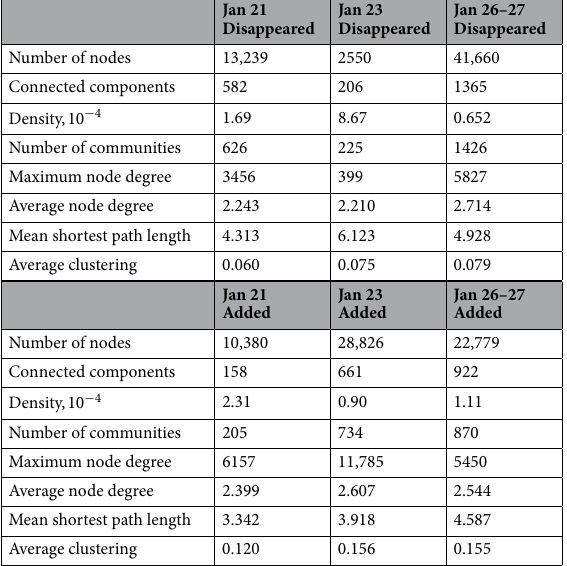
Table 3. Network properties of “added” and “disappeared” social connections before and during internet outages.